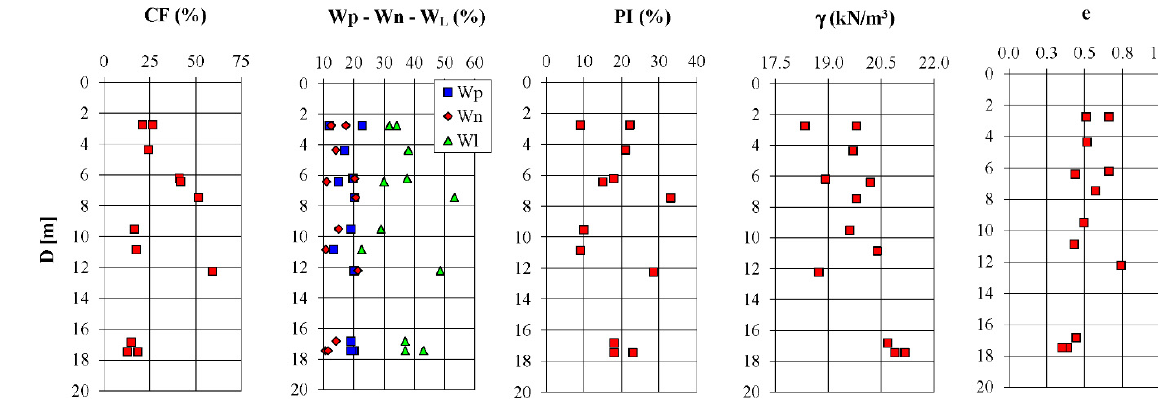
Figure 6. Index properties of Caronia area, where: D = Depth, CF = Clay Fraction, W P = Plastic Limit, W n = Water Content, W L = Liquid Limit, PI = Plasticity Index, γ = Total Unit Weight and e = Void Ratio.